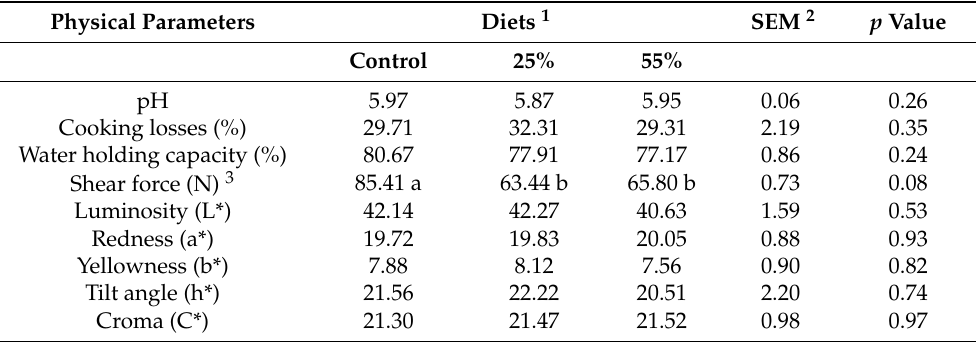
Table 3. Physical quality of the Longissimus lumborum muscle of goats fed forage cactus as a substitute for Tifton 85 hay.